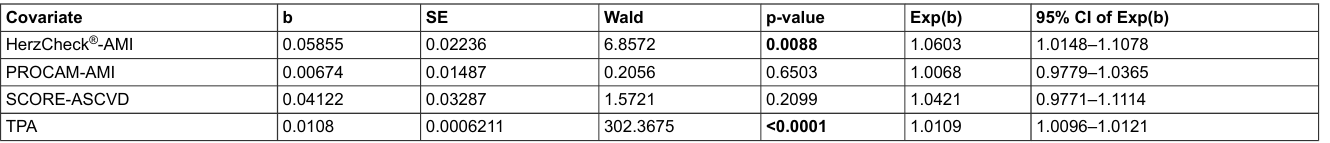
Table 7: Cox proportional hazards model survival analysis for the secondary outcome using the covariates HerzCheck ® , PROCAM, SCORE and TPA. Covariate b SE